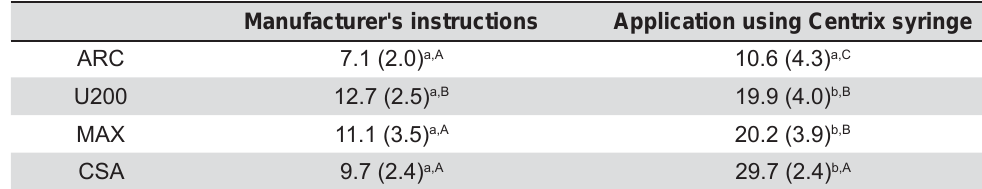
Table 2- Push out bond strength (MPa) means according to resin cement and application techniqu e